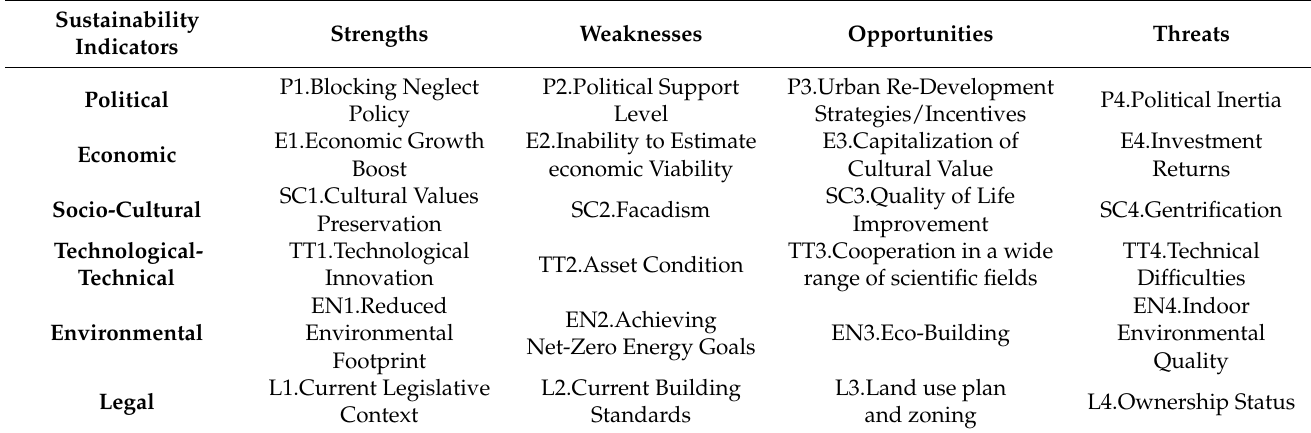
Table 5. Adaptive reuse SWOT-PESTLE